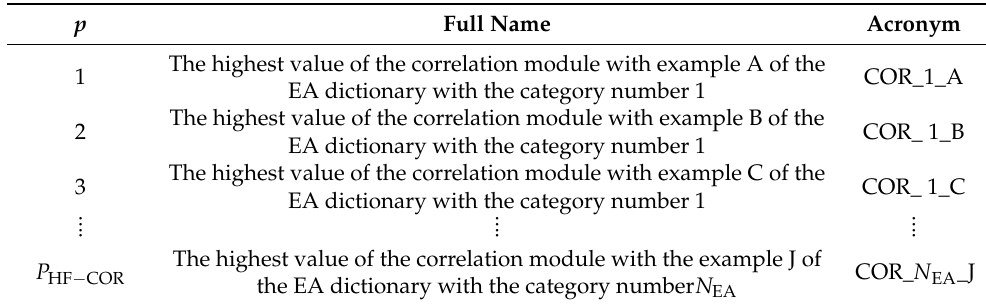
Figure 14. The absolute value of cross-correlation with the maximum value marked for example measurement data.